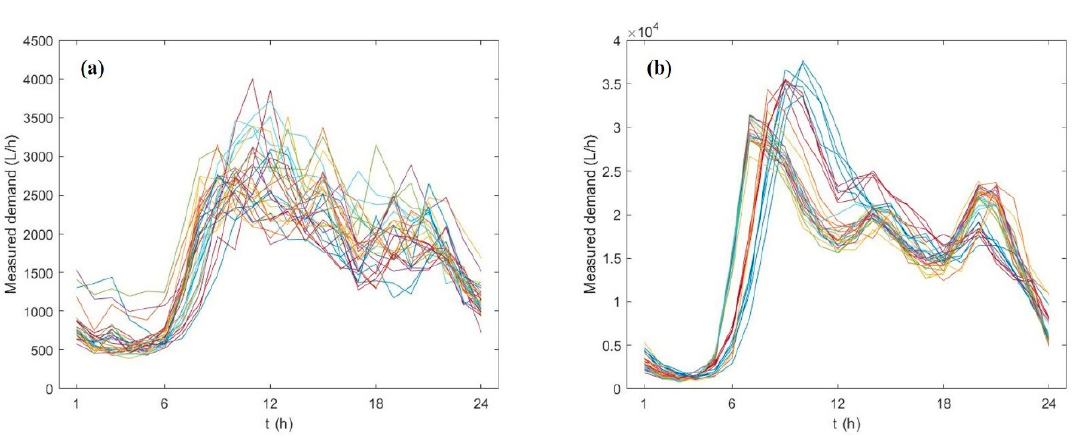
Figure 1. Patterns of aggregated measured hourly demand for 31 days for both Case study 1 ( a ) and Case study 2 ( b ).